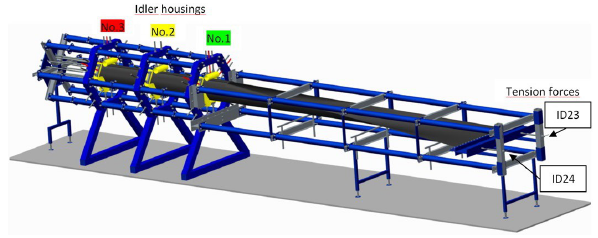
Figure 1: 3D geometric model of a pipe conveyor